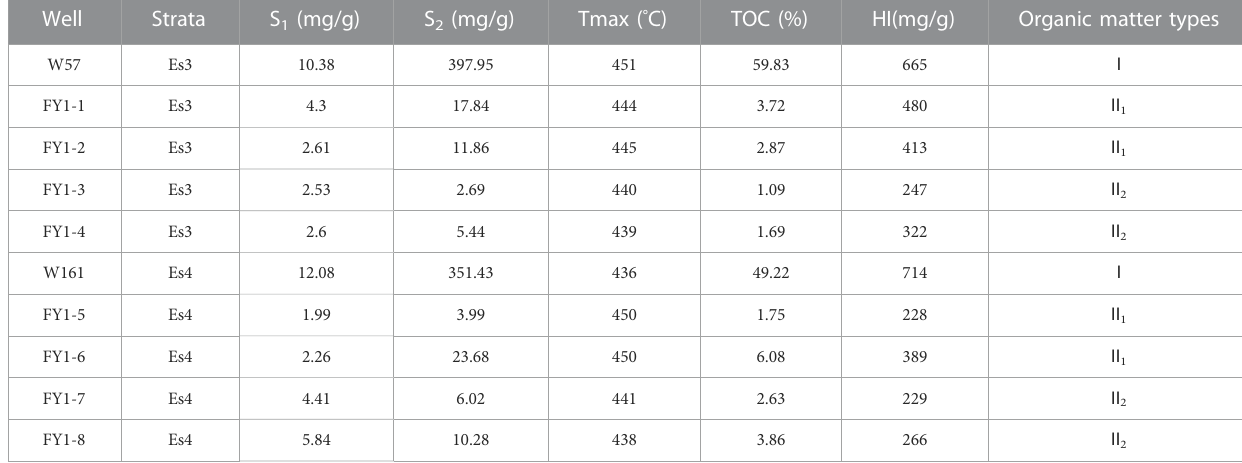
TABLE 3Resultsof Rock-Evalpyrolysisof source rockswith different organic matter types inthe Es3and Es4members.The determination of organic mattertypes is based on Tmax and HI (Espitalié et al., 1985). Note that the data for these samples were obtained from the published literature (Li et al., 2018; Sun et al., 2019).